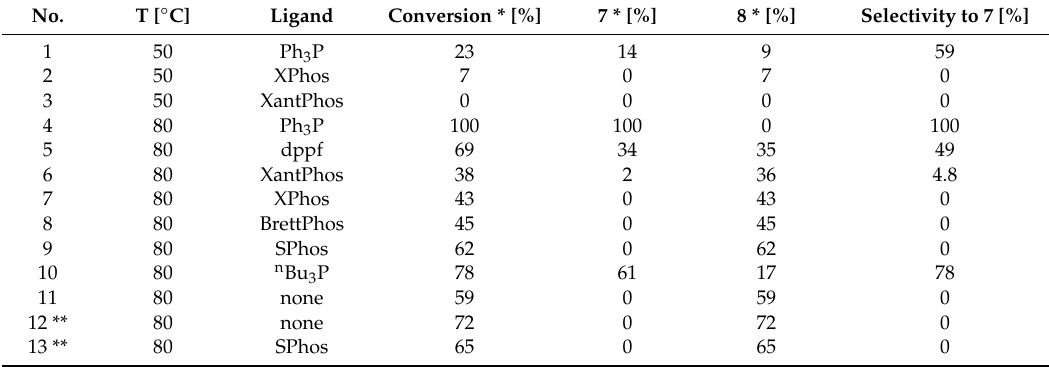
Table 2. Screening of bases and